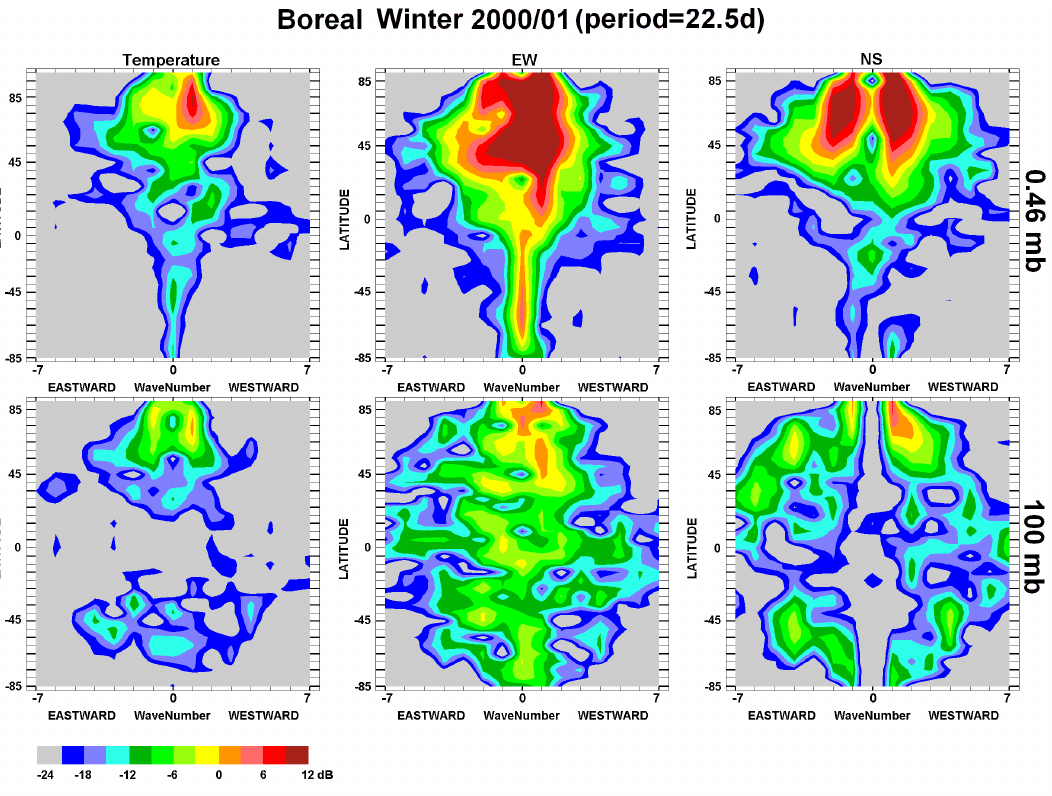
Fig. 10. The same as Fig. 8, but for the oscillation with the period near 22